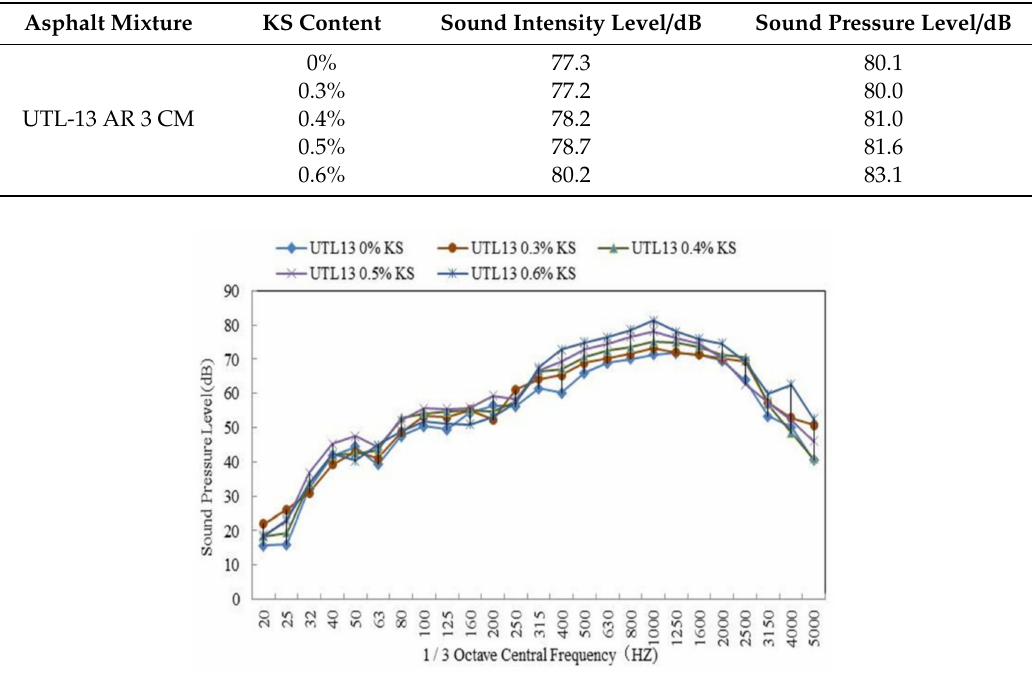
Table 6. Noise test results of UTL with di ff erent KS contents.